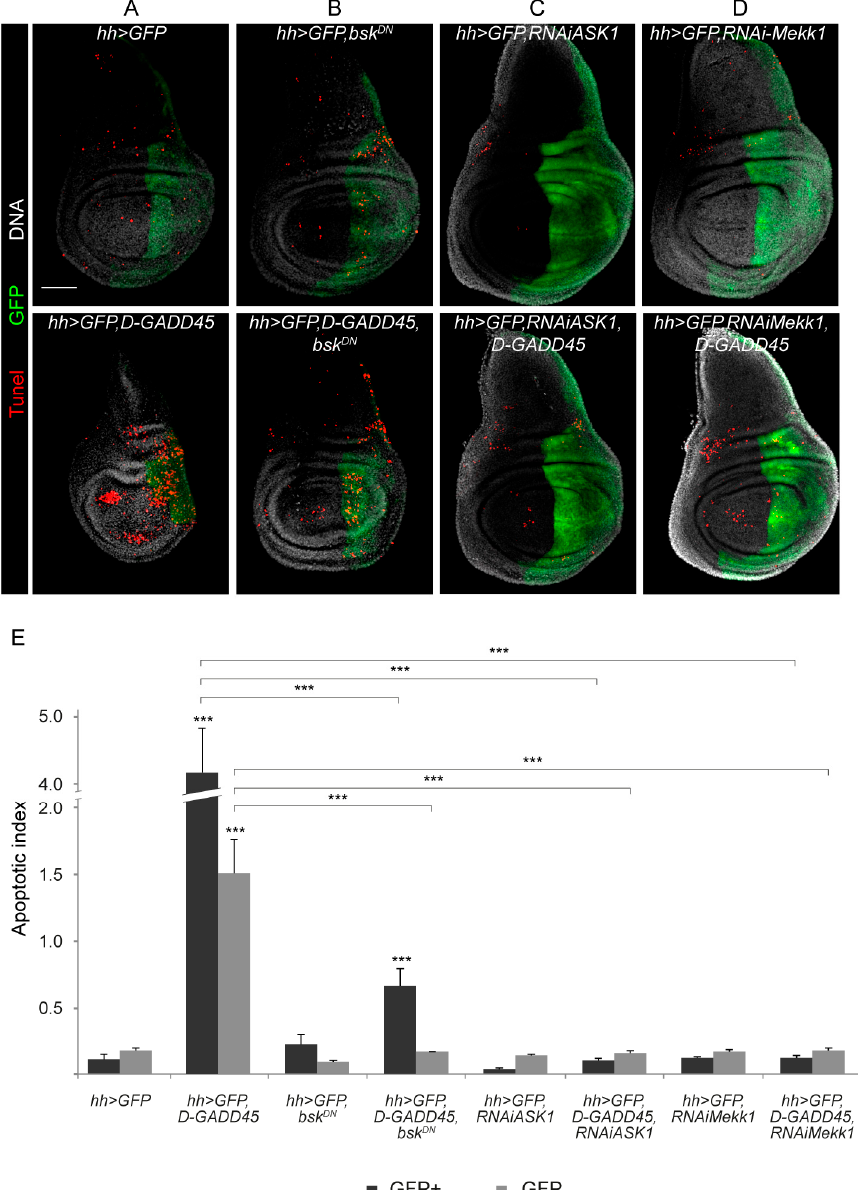
Figure 1. Sustained expression of D-GADD45 induces JNK-dependent cell death. ( A – D ) TUNEL assay of wing discs labeling apoptotic cells after sustained expression of each construct in the posterior ( hedgehog , hh ) compartment. Apoptotic cells (red), posterior compartment (green) and DNA (white). Scale bar: 50 µ m. ( E ) Histogram showing the apoptotic index for each genotype in the green fluorescent protein (GFP)-positive and GFP-negative compartments. Error bars indicate standard deviation. N ≥ 4 discs for each genotype. ** p < 0.01. *** p < 0.001.